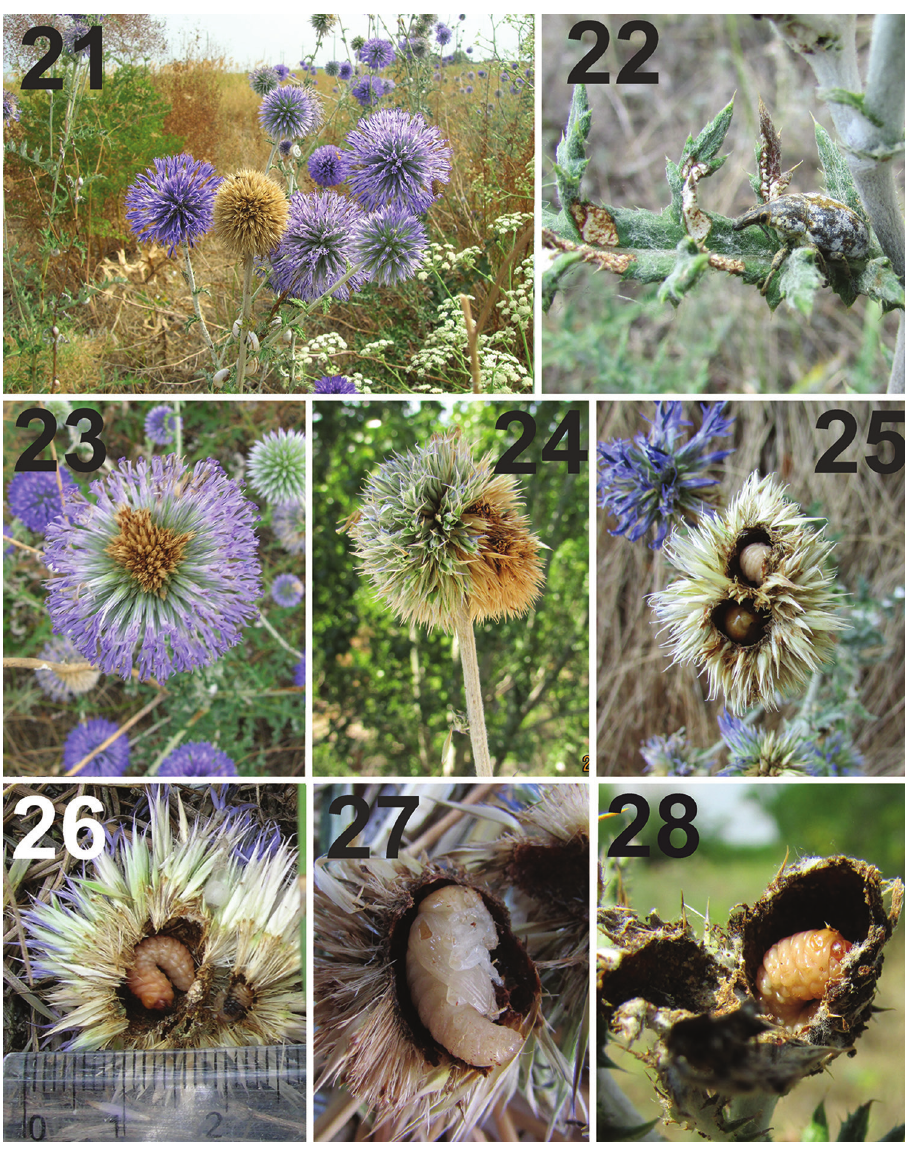
Figures 21–28. Habitat, life cycle, and immature stages of Larinus vulpes . 21 Habitat with flowering Echinops ruthenicus (Cyrilivska Spit) 22 Adult and the damaged leaf of Echinops ruthenicus by weevil 23 When larva begins its development, upper parts of the flower head die and are visible as a light brown spot 24 Pupa cell results in deforming of flower head 25 Larva and pupa in the same inflorescence 26 Two larvae in the same flower head, right larva is younger and dead 27 Pupa in the inflorescence 28 Mature larva in a chamber outside a flower head. All photos SV